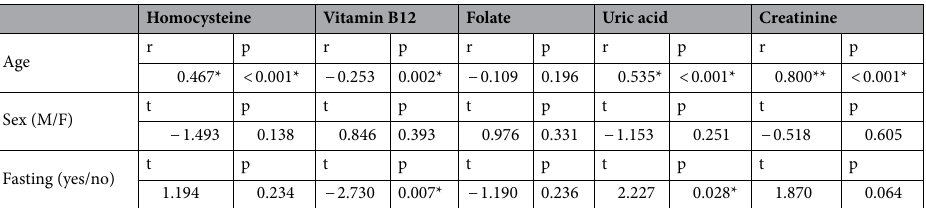
Table 1. Linear correlations (r) between age and metabolites; unpaired t-test (t) between sex and metabolites; unpaired t-test (t) between fasting state and metabolites. The analysis includes outliers. Further analysis after outlier exclusion is described in the text. *p-value ≤ 0.05 or moderate correlation 0.4 < r < 0.7. **Strong correlation with r ≥